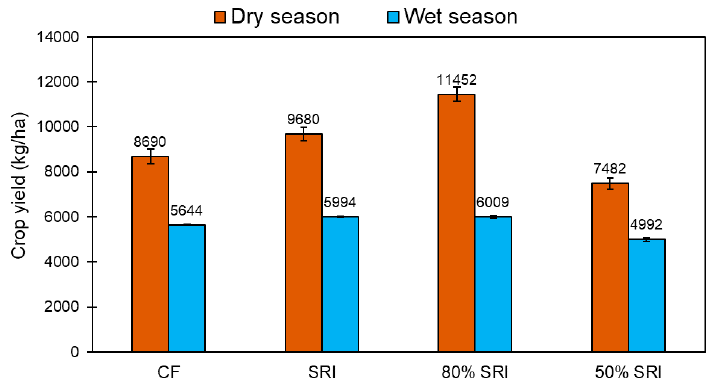
Figure 4. Dry and wet seasons rice crop yields for continuous flooding (CF), system of rice intensification (SRI), 80% SRI, and 50% SRI. 80% SRI and 50% SRI refers to 80% and 50% of the SRI ponding depth, respectively.